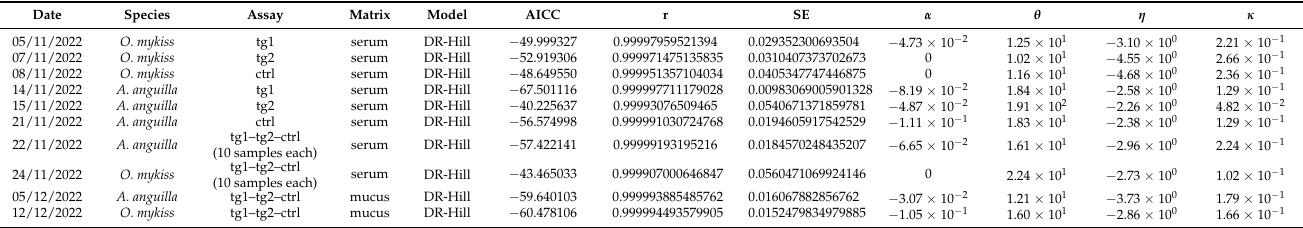
Table 2. Results of statistical models ranking, standard error of regressions, and coefficient parameters of EIA assay cortisol standard datasets per species and test group. AICC: Akaike information corrected criterion; r: correlation coefficient; SE: standard